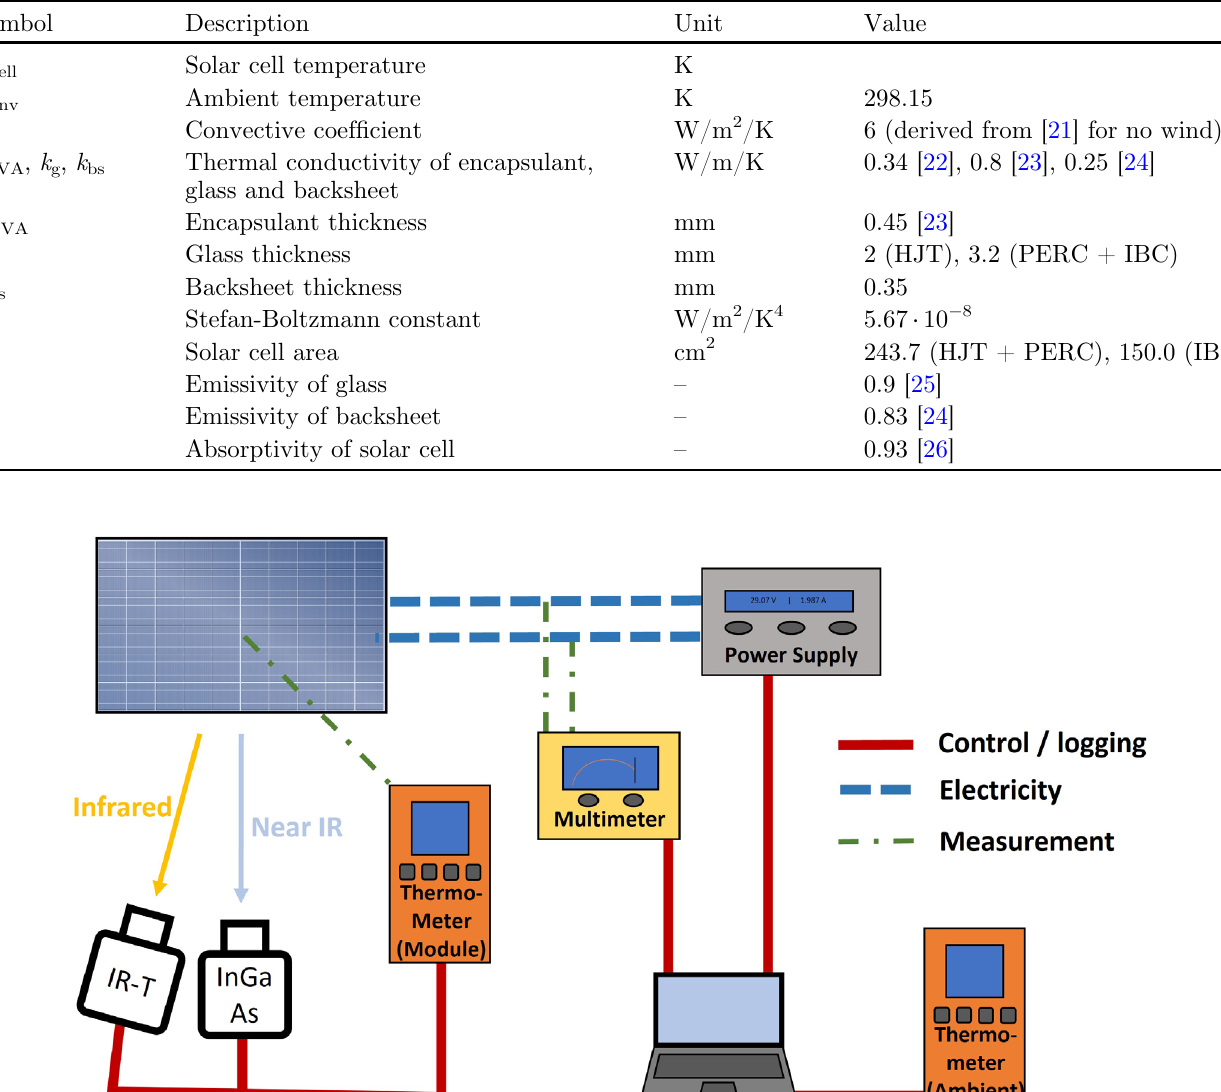
Table 2. Description of used parameters for energy balance calculations in equation (5) to achieve saturation temperature of backpowered photovoltaic modules.